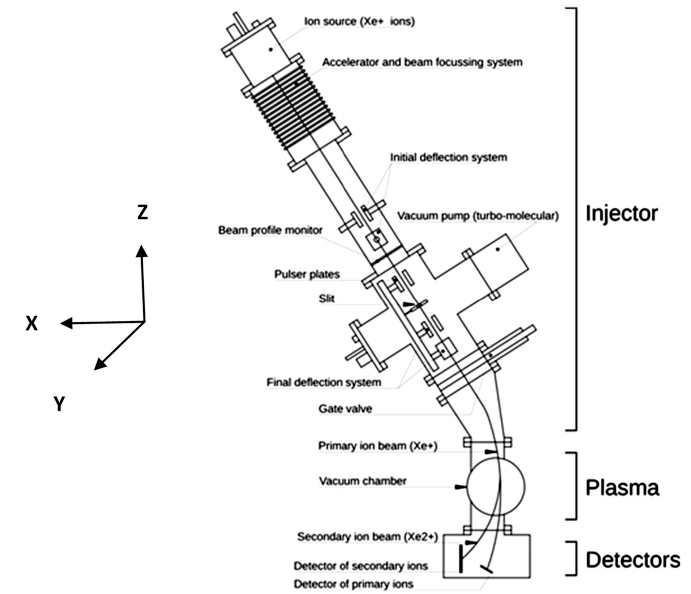
Figure 11. Primary beamline of ISTTOK HIBD injector .